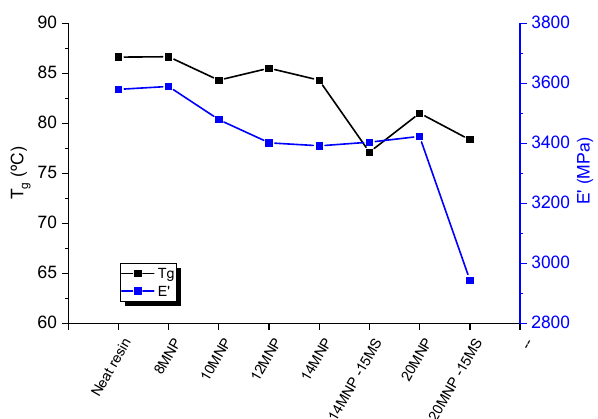
Figure 4. DMTA results showing the variation in the T g and storage modulus under the different conditions tested.